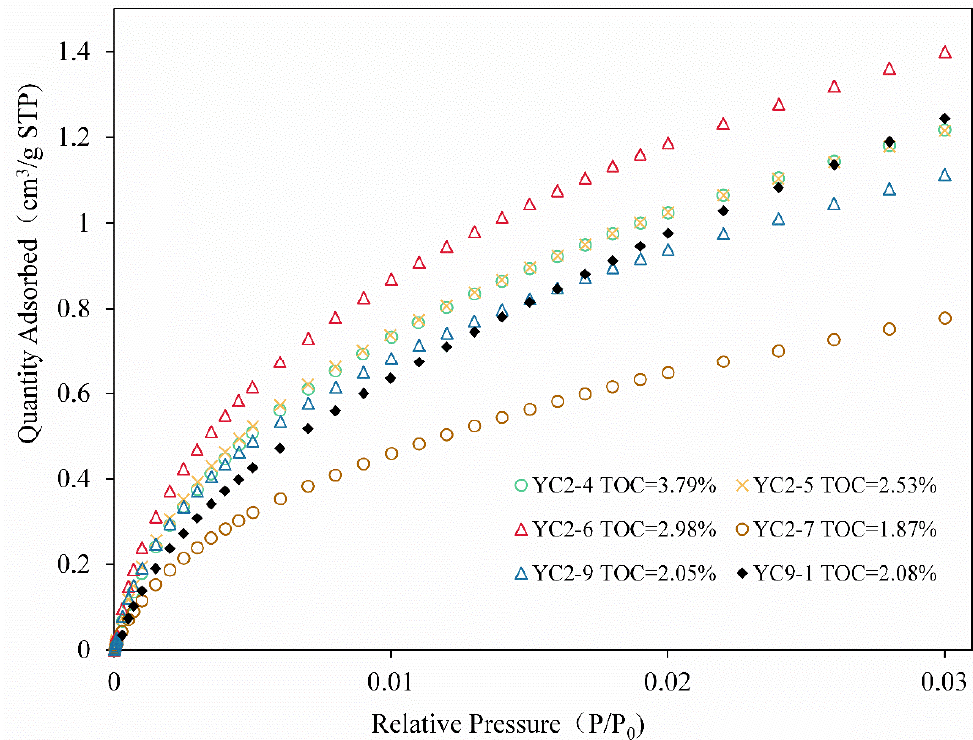
Figure 8. LPCA curves of selected shale samples with different TOC. The adsorption capacity of sample YC9-1 is significantly greater than that of the sample from well YC2 (e.g., YC2-9) with a similar TOC.